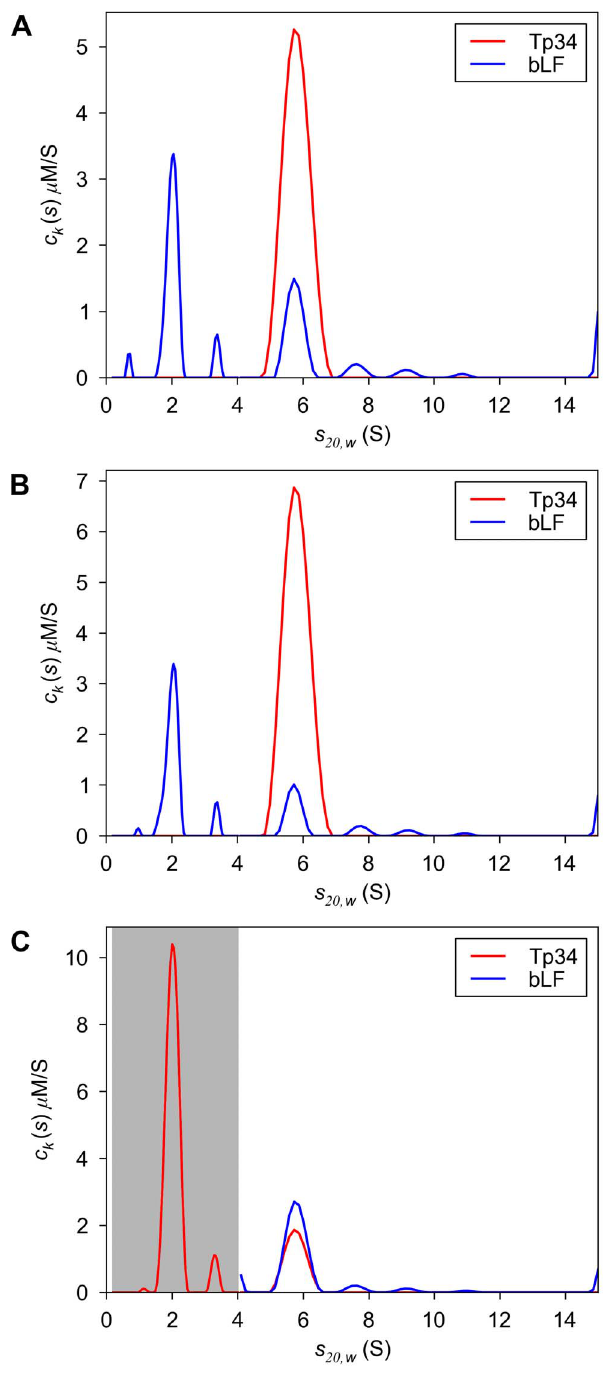
Figure 5. MSSV analysis of the data in Fig. 4. Shown are the c k ( s ) distributions of both components calculated in a global fit (A) in an unconstrained fit; (B) using mass conservation MSSV; and (C) using both mass conservation and excluding of bLF from the range of sedimen- tation coefficients between 0 and 4 S (shaded in gray).